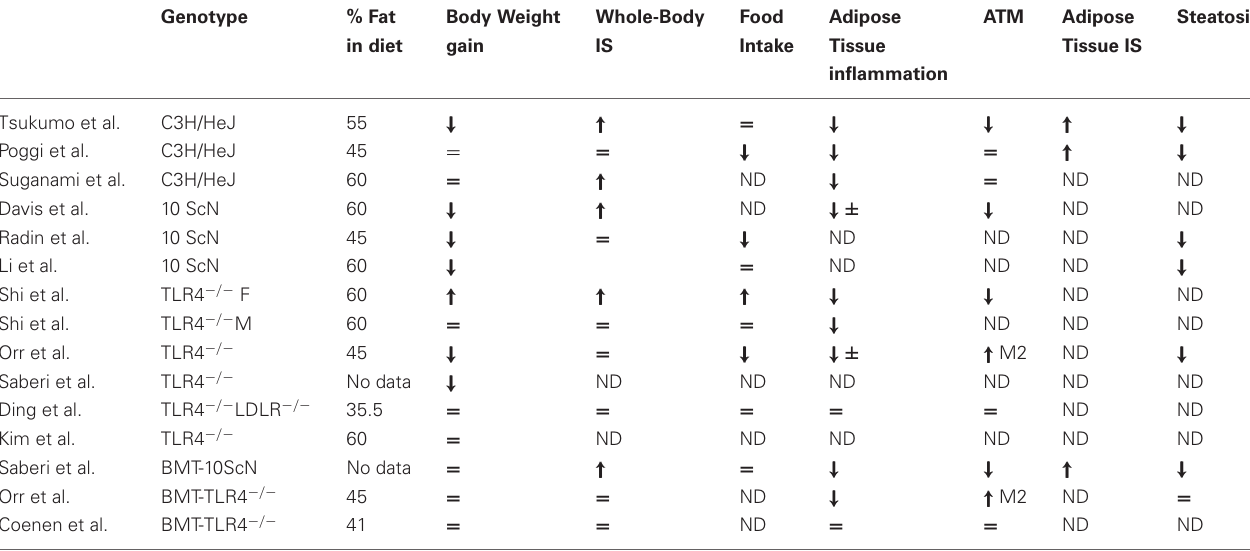
Table 1 | Phenotype of the different TLR4-deficient mice fed with a high-fat